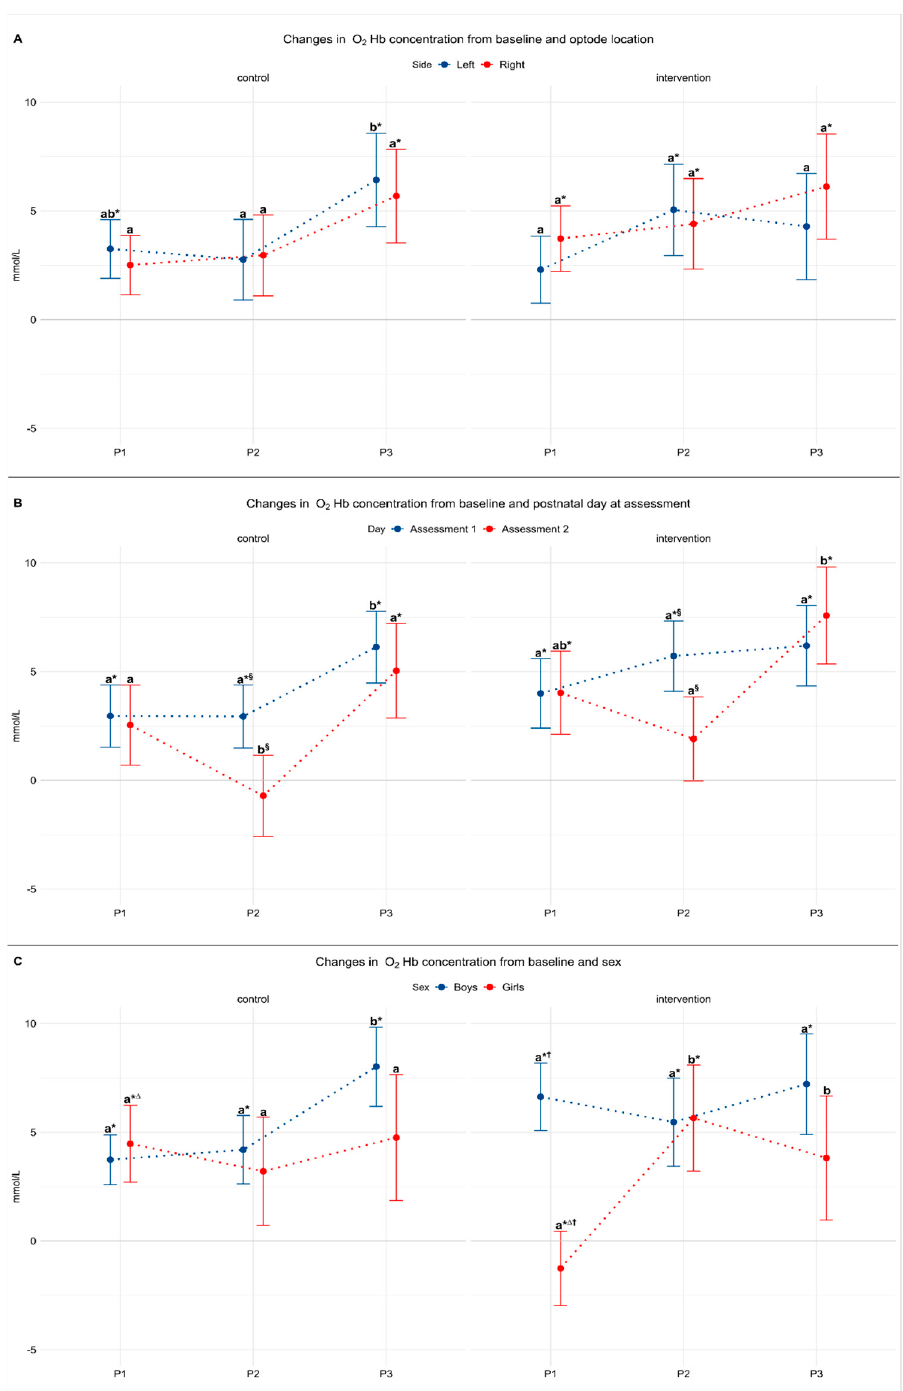
Figure 4. Model estimates adjusted for sex, gestation, and baseline oxygenation. Values are mean with 95% confidence intervals. ( A ) Effect of laterality (control N = 18, intervention N = 14). ( B ) Effect of postnatal day (control N = 19, intervention N = 16). ( C ) Effect of sex (control N = 18, intervention N = 14). * Significant change from baseline. a,b Different letters represent significant differences among periods. § Significant difference between assessment 1 and assessment 2. ∆ Significant group difference. † Significant sex difference. Statistical significance taken as p < 0.05 for all comparisons. P1: period 1 (smell exposure in intervention group). P2: period 2 (taste exposure in intervention group). P3: period 3 (feeding period in both groups). O 2 Hb = oxygenated hemoglobin.